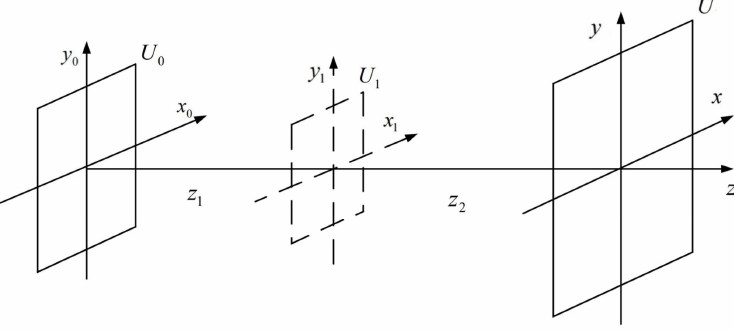
Figure 7. Schematic of DBFT.